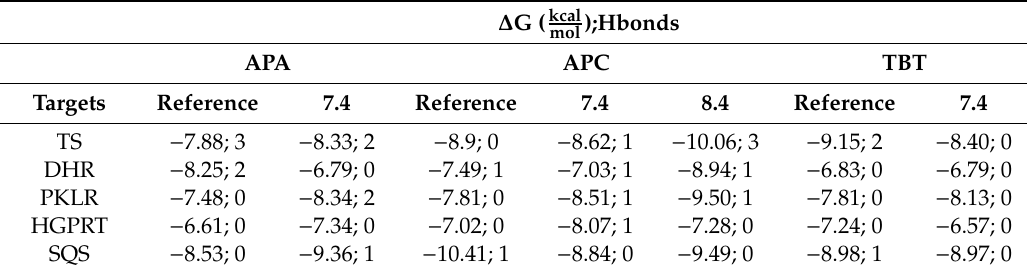
Table 5. Predicted binding free energy and hydrogen bonds. The metabolite molecules were docked in five Homo sapiens targets (additional data in Table A3). Reference, 7.4 or / and 8.4 indicate pH of the